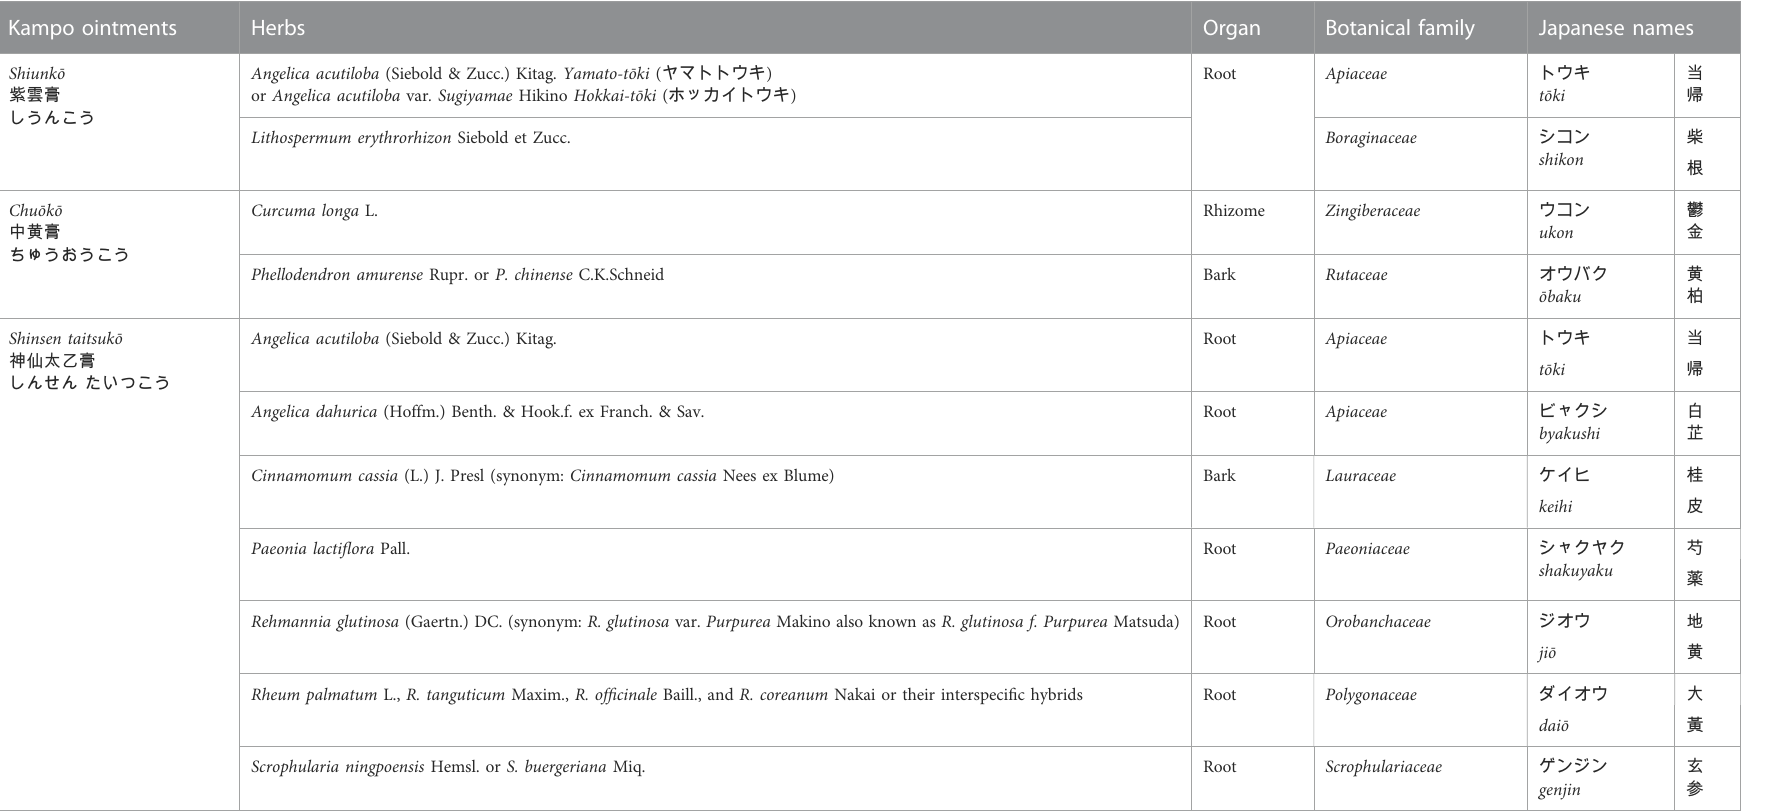
TABLE 1 Herbal medicines from Kampo topical ointments: Japanese and Latin denominations, plant organ used, and botanical family for each plant. Kampo